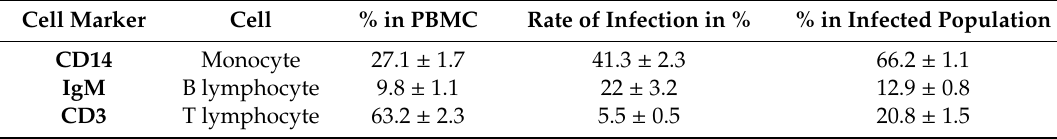
Figure 4. Virus transfer from EHV-1-infected PBMC subpopulations to endothelial cells under dynamic flow condition. PBMC were infected with Ab4-wt or mutant viruses at an MOI of 0.1 for 24 h. Infected PBMC were FACS-sorted and flow chamber assays were was performed for ( A ) T-lymphocytes, ( B ) B-lymphocytes, and ( C ) monocytes. Virus plaques were counted at 24 hpi. The data represent the mean of two independent experiments ± SD. For statistical analysis, one-way ANOVA followed by correction for multiple comparisons test were performed; *— p < 0.05, **— p < 0.01, ***— p < 0.001. Table 2. Ab4-wt infection of PBMC subpopulations. The data represents the mean ± SD of three independent and blinded experiments.